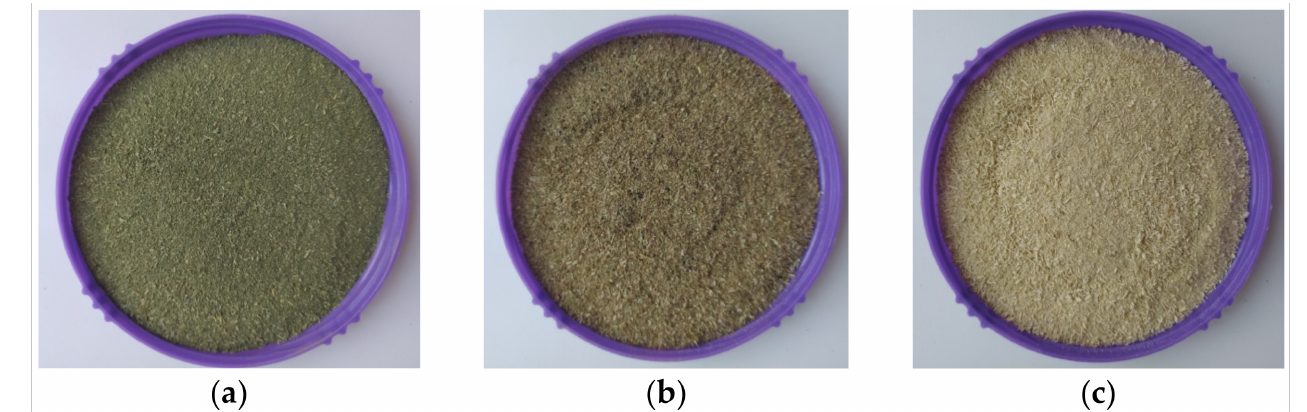
Figure 1. Photographs of the dry biomass AR: ( a ) leaves; ( b ) inflorescences; and ( c )